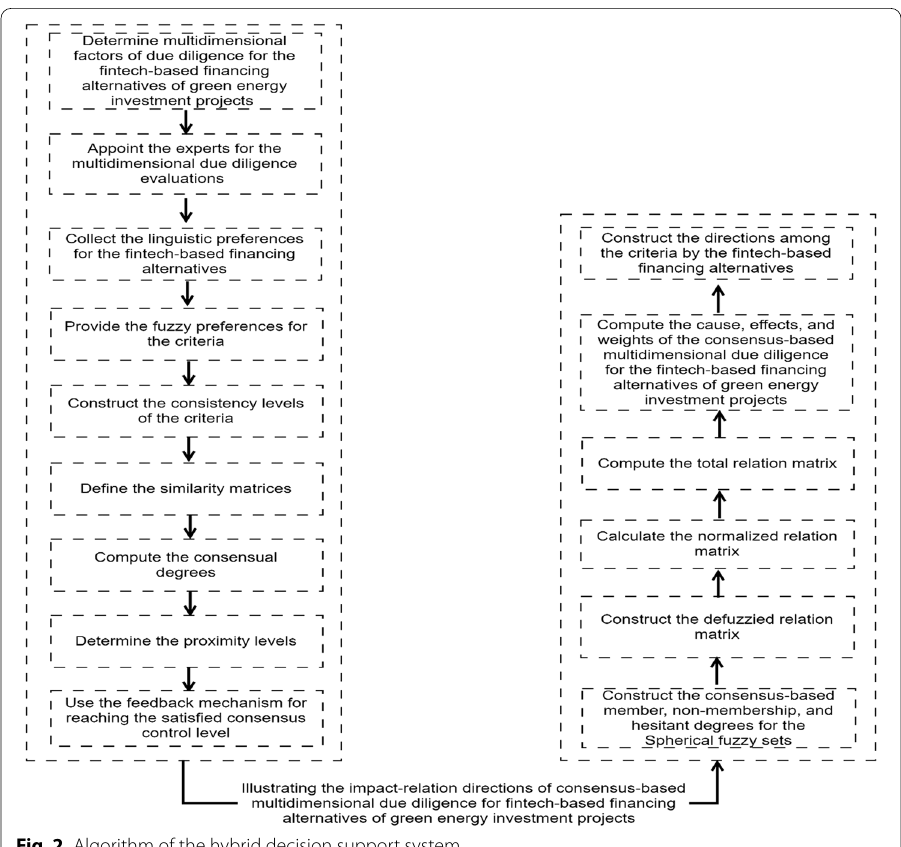
Fig. 2 Algorithm of the hybrid decision support